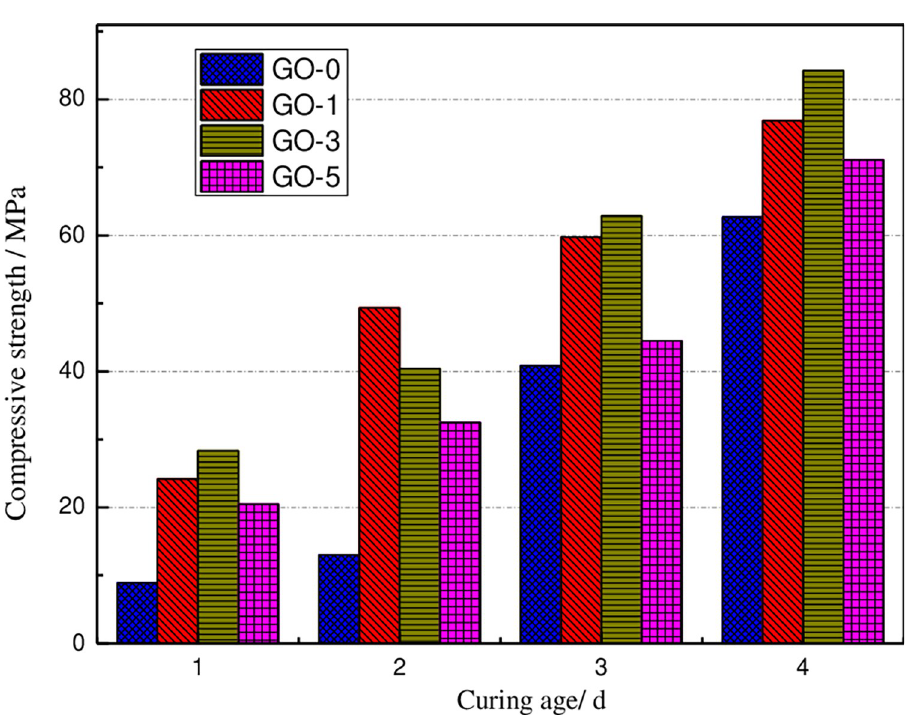
Fig 4. Compressive strength of GO cement paste under various curing